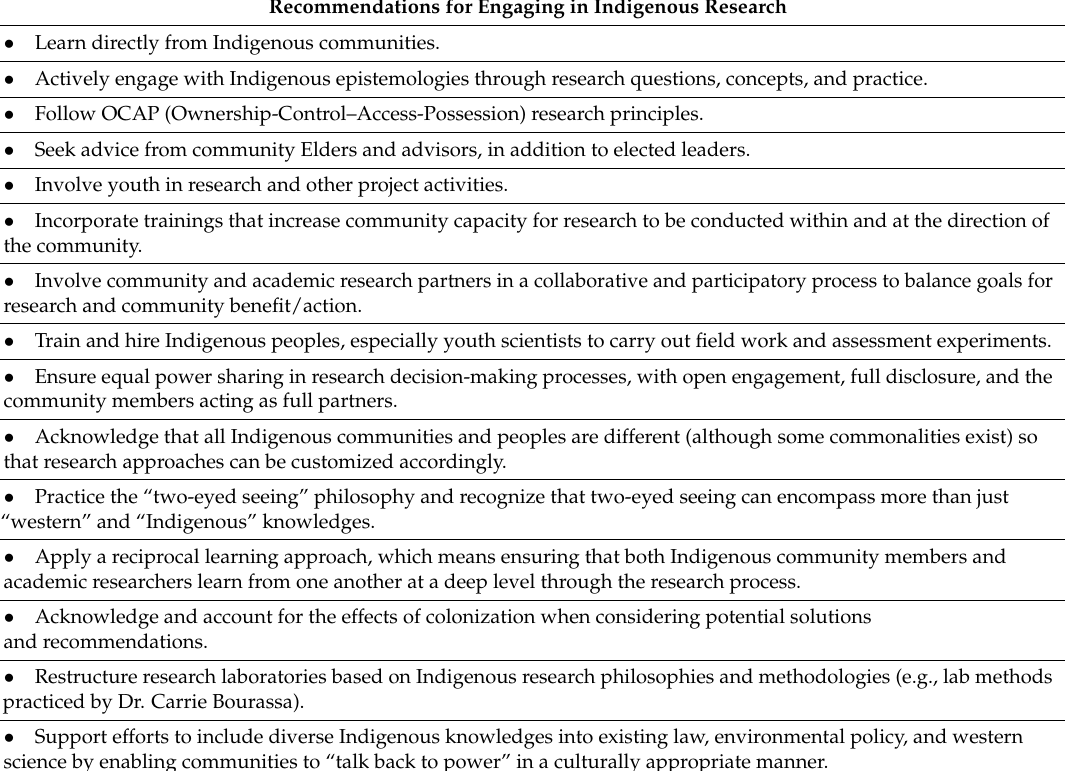
Table 1. Recommendations for engaging in Indigenous